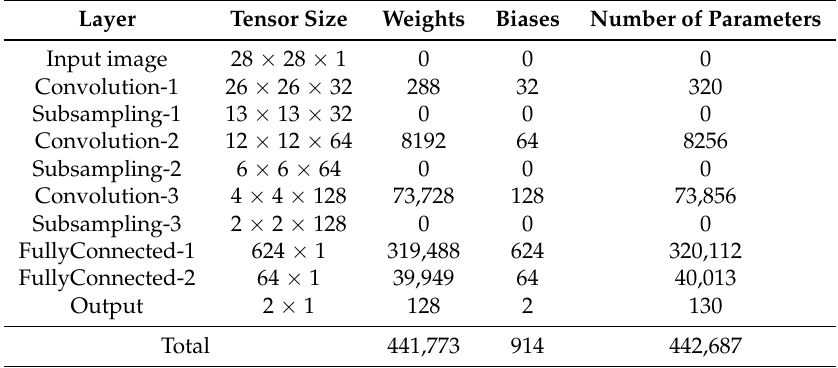
Table 3. Model complexity.